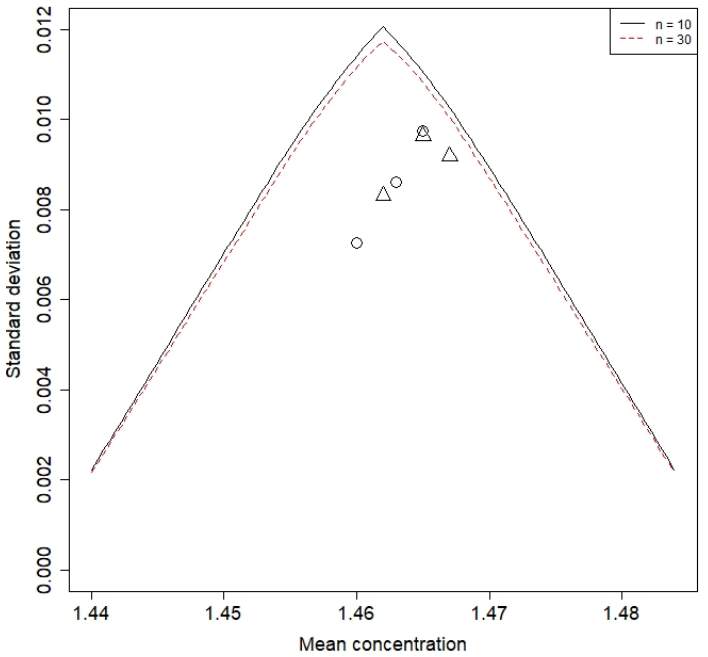
Figure 4. Release criterion acceptance region (Triangle corresponds to Group 2 batches; circle corresponds to Group 1 batches).